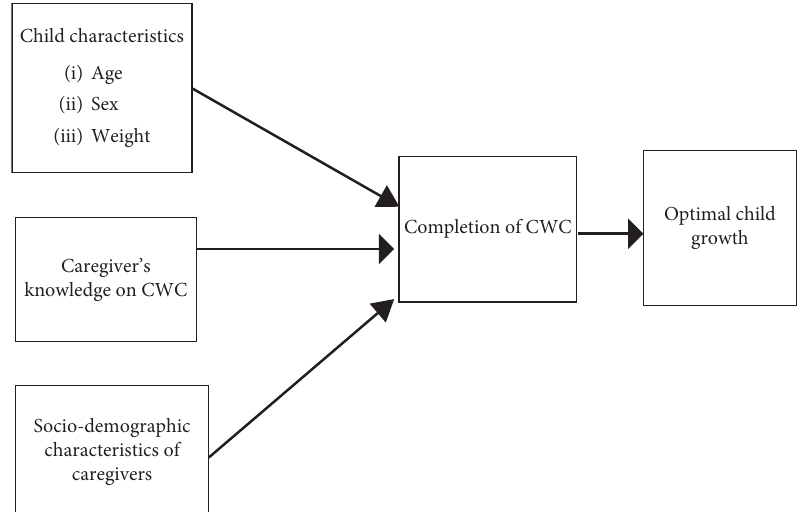
Figure 1: Conceptual framework of the child welfare clinic